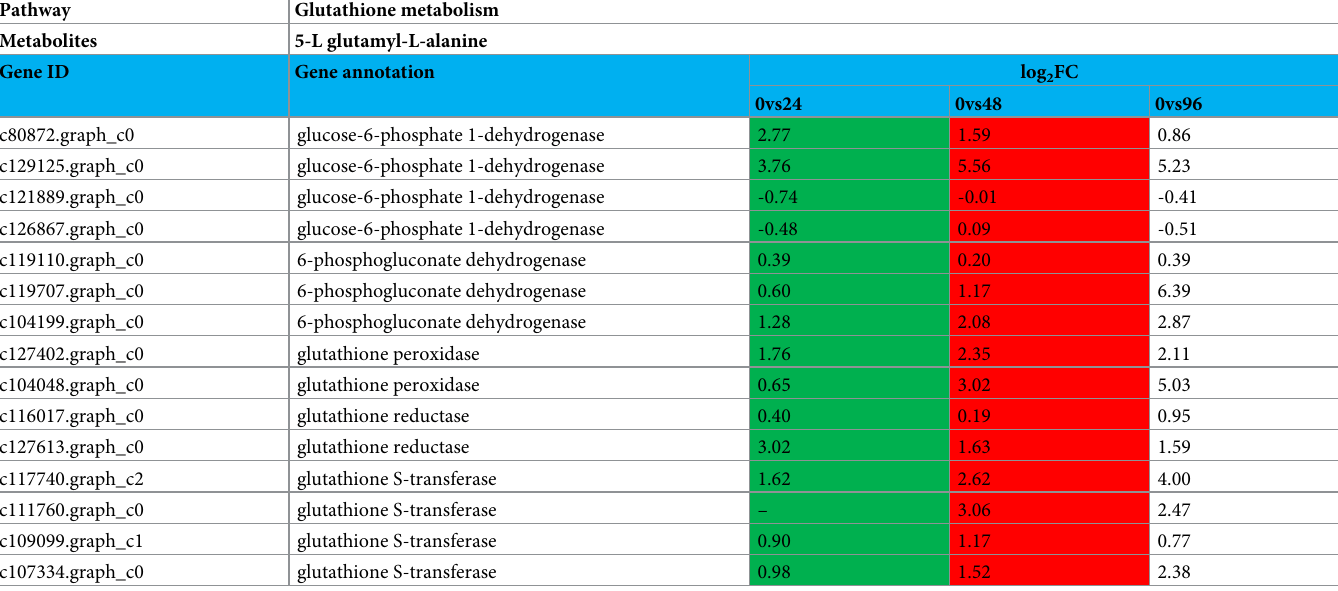
Table 6. Annotations of differentially expressed genes in response to drought in glutathione metabolites of Larix olgensis .